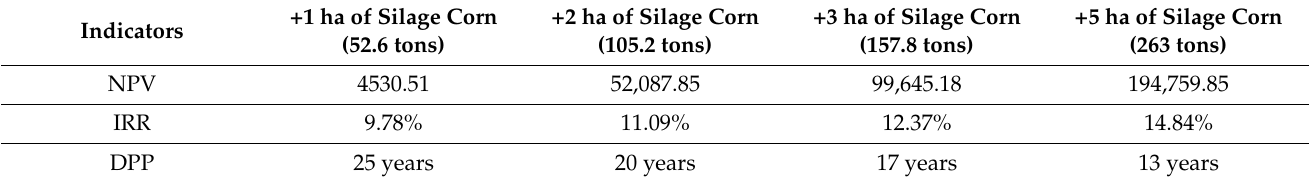
Table 10. Different scenarios of adding corn silage for location